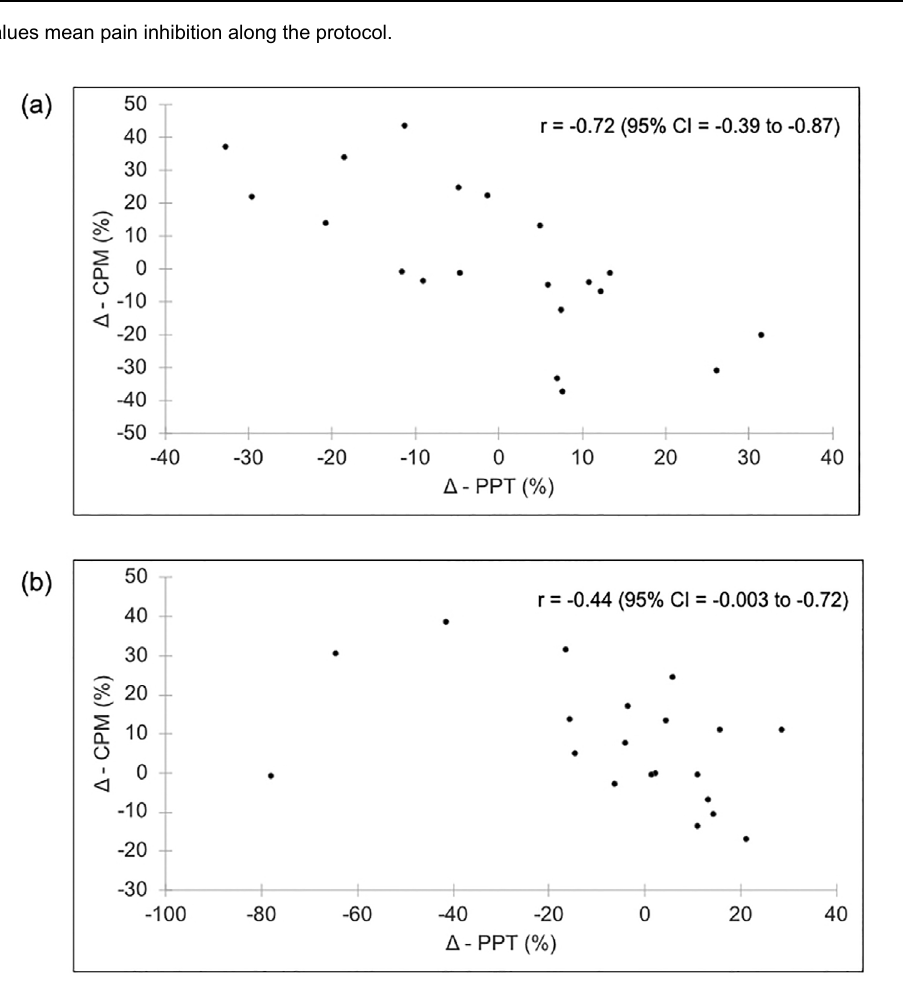
Figure 2- A scatter plot showing the negative correlation between the relative change in conditioned pain modulation (Δ-CPM) and relative change in pressure pain threshold (Δ-PPT) from baseline to post-stress session in (a) healthy individuals and (b) temporomandibular disorders (TMD)